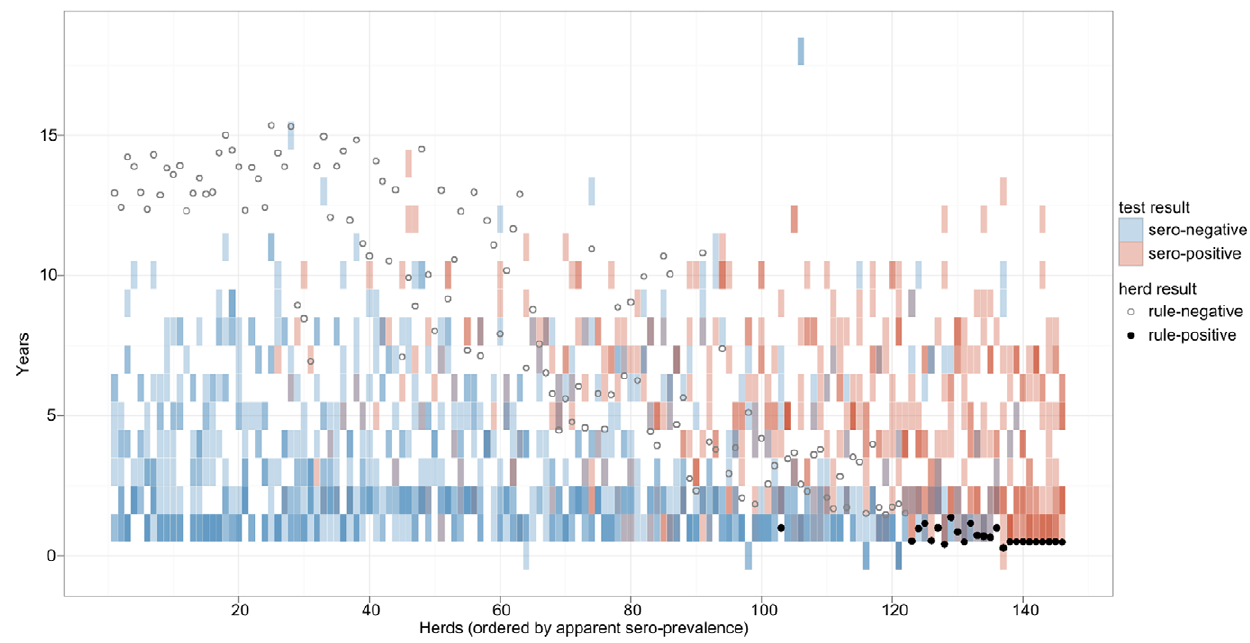
Figure 3. Age stratified animal-level seroprevalence based on raw test results (not adjusted for clustering within-herds or diagnostic test imperfections).